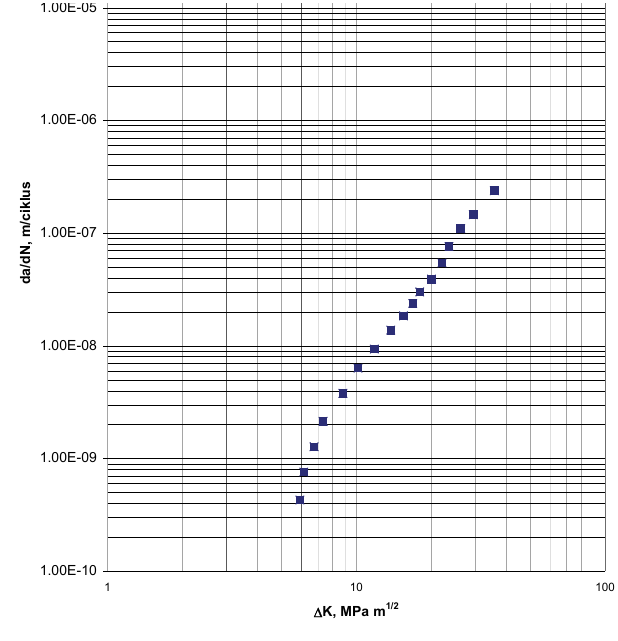
Figure 1: Diagram da/dN-K for specimen PM-1-1n, 20°C.